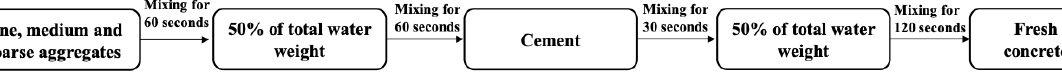
Figure 1. Concrete mixing process.